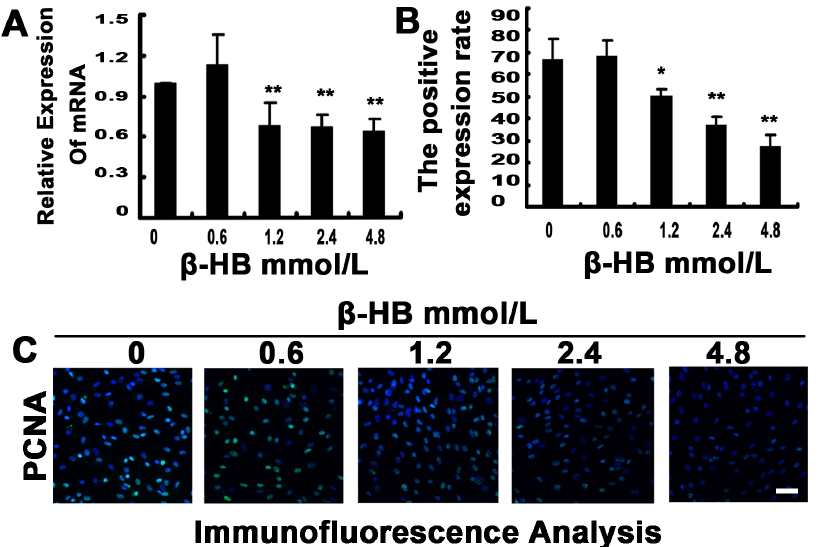
Figure 7. Effect of b -HB on PCNA induction. Cells were incubated 48 h with b -HB (0, 0.6, 1.2, 2.4 or 4.8 mM) in serum-free medium. A) PCNA mRNA was detected by Q-PCR, and the ratio of PCNA to b -actin was calculated. B) The percentage of PCNA was measured from the immunofluorescence in figure 7C. C) Protein localization of PCNA was detected by immunofluorescence. The mean of three independent experiments is shown. *p , 0.05, **p , 0.01 versus the control group.